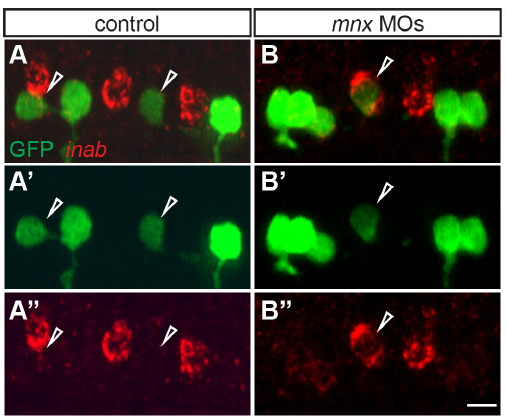
Figure 4. inab is expressed in MiP-CaP hybrids generated by Mnx protein knockdown. ( A–B ) Z-projections of confocal stacks of control and Mnx MO-injected nrp1a:GFP embryos labeled with inab riboprobe and anti-GFP antibody. At 26 hpf, inab is not expressed in GFP + MiP MNs in control embryos (arrowheads, A-A 0 ), but is expressed in a small percentage of GFP + MiP MNs in MO-injected embryos (arrowhead, B-B 0 ). Scale bar, 10 m m.